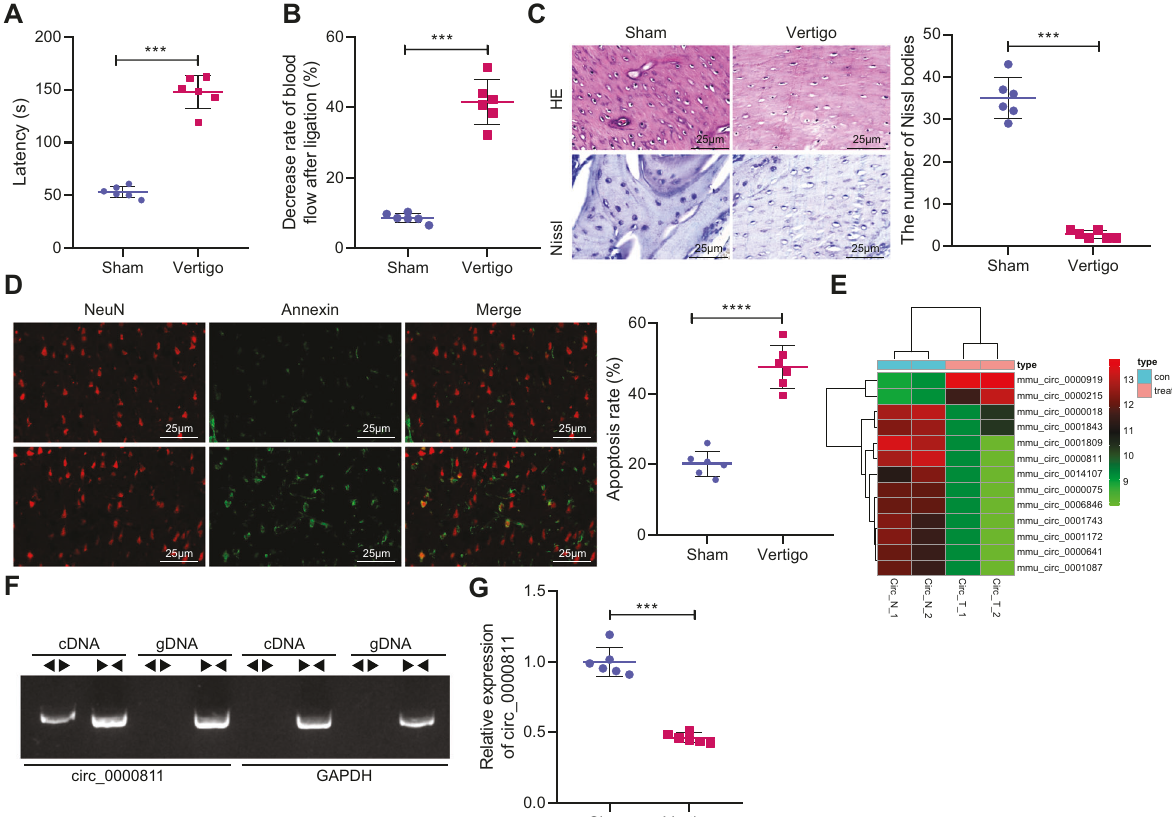
Fig. 1 Circ_0000811 was down-regulated in brain tissues of mice with experimental CI-induced vertigo. A The escape latency of mice with CI-induced vertigo and sham-operated mice; B the decrease rate of blood fl ow in the MVN after ligation of CCA and SCA in mice with CI- induced vertigo and sham-operated mice; C H&E and Nissl staining to detect MVN histopathological changes in mice with CI-induced vertigo and sham-operated mice; D NeuN/Annexin counterstaining to detect the apoptotic rate of neurons in the MVN of mice with CI-induced vertigo and sham-operated mice; E the heat map of the expression of signi fi cantly differential circRNAs screened by circRNA sequencing for cerebral ischemic vertigo; F agarose gel electrophoresis to detect the ampli fi cation of circ_0000811 in cDNA and gDNA; G qRT-PCR to determine the level of circ_0000811 in the MVN of mice with CI-induced vertigo and sham-operated mice. *** p < 0.001 compared with the Sham group. The independent sample t test was applied for the comparison between two groups. CI cerebral ischemia, circRNA circular RNA, cDNA complementary DNA, gDNA genomic DNA, MVN medial vestibular nucleus, CCA common carotid artery, SCA superior cerebellar artery, H&E hematoxylin and eosin, qRT-PCR quantitative reverse-transcription polymerase chain reaction, NeuN neuronal